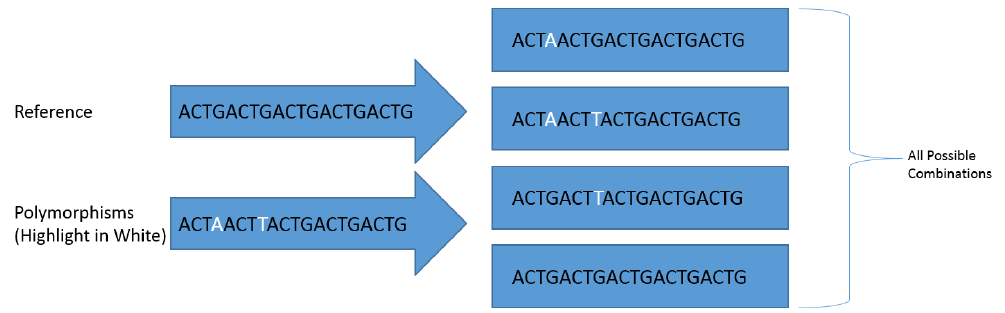
Figure 1. A visual representation of how the Biostars 175929 tool produces sequences containing all polymorphism combinations.